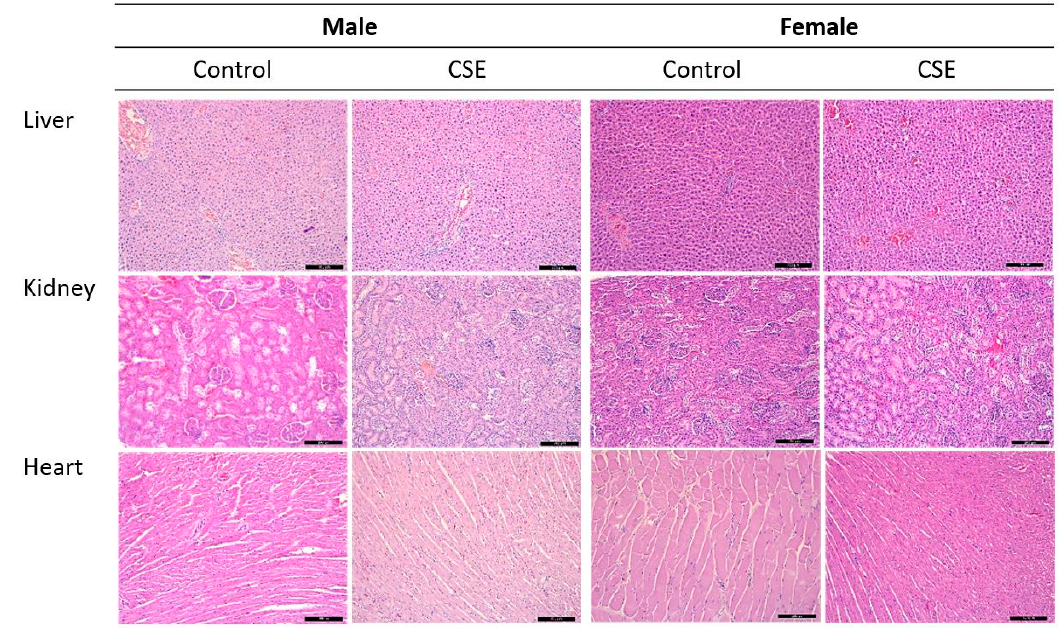
Figure 2. Representative microscopic findings for the liver, kidneys and heart of female and male Wistar rats treated with 1 g / kg b.w. CSE in aqueous solution and the controls for 28 days. Scale bar = Wistar rats treated with 1 g/kg b.w. CSE in aqueous solution and the controls for 28 days. Scale bar = 200 µ 200 μ m.